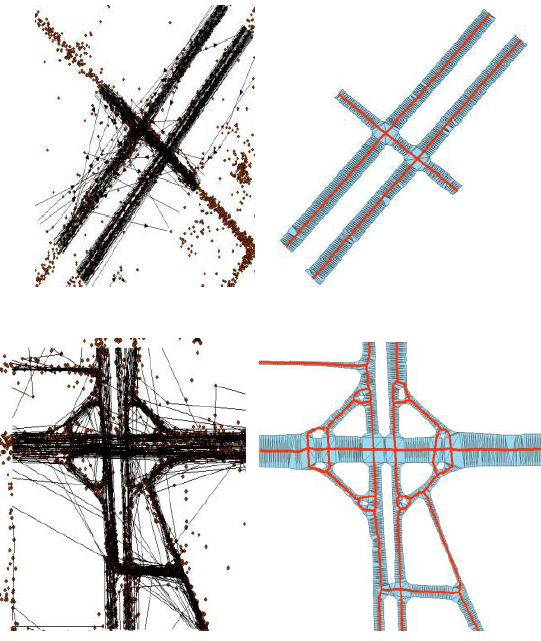
Figure 3. Center line extraction using Delaunay triangulation.